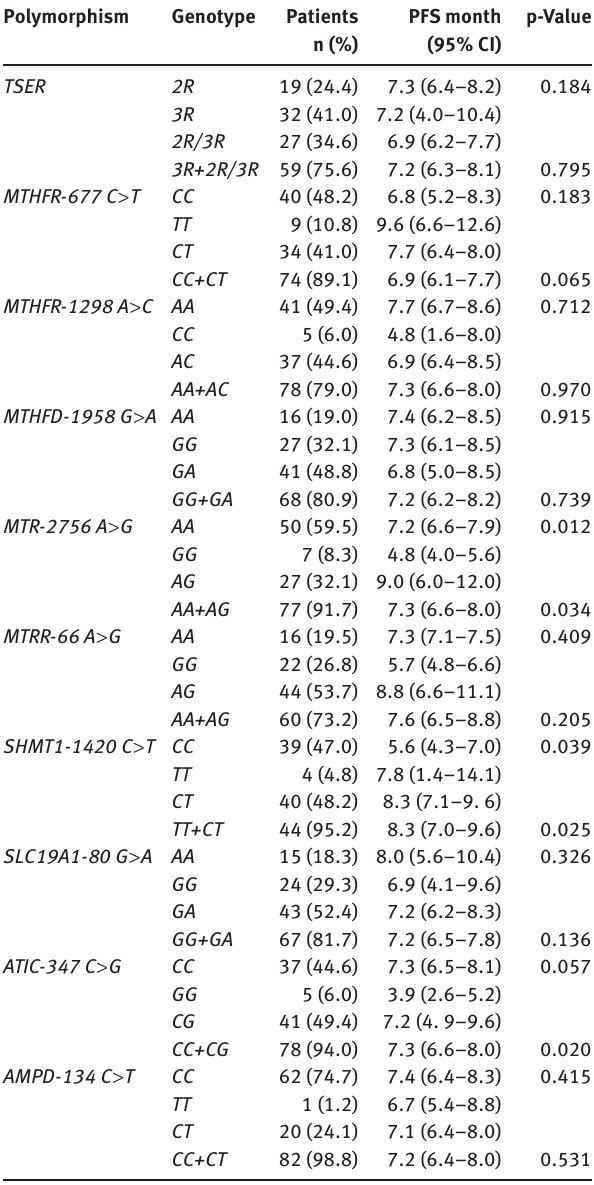
Table 1 Clinical outcome according to